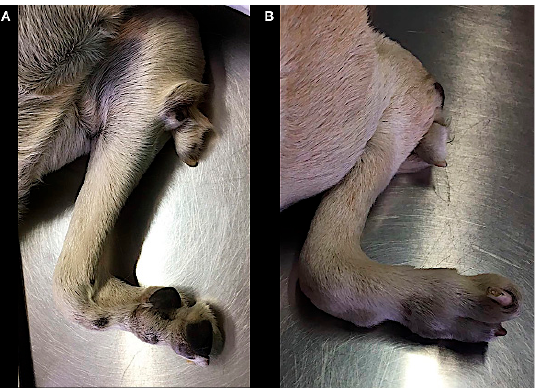
Figure 1. Case 1. Medial ( A ) and lateral ( B ) views of the right forelimb.